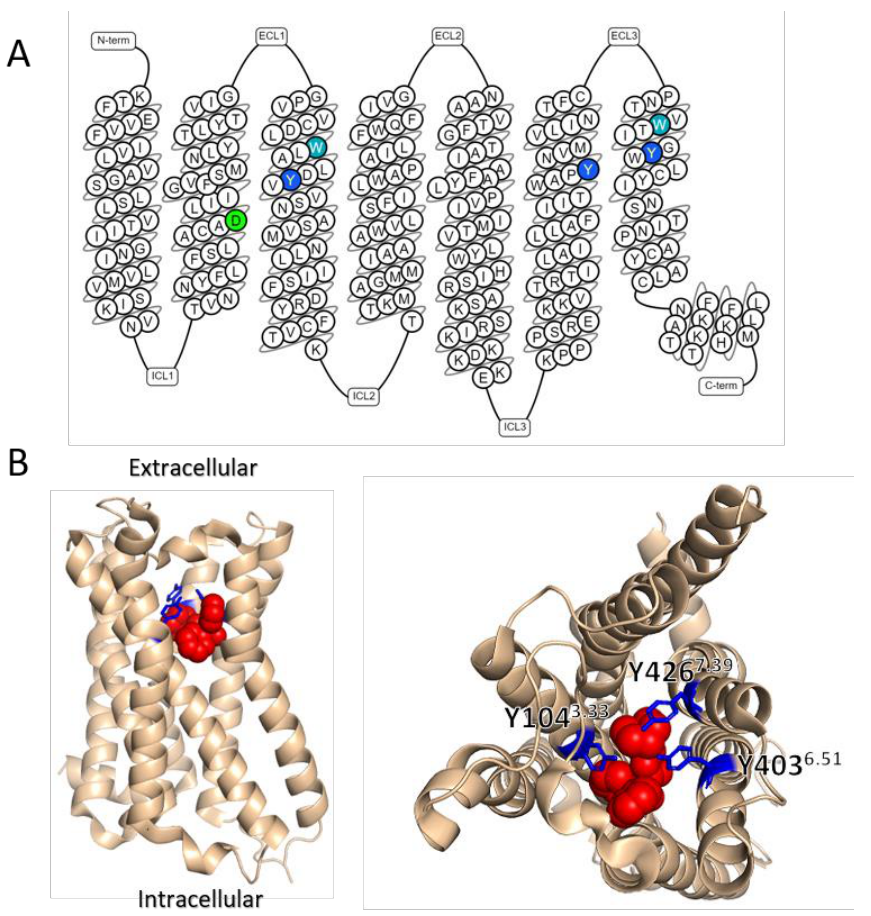
Figure 2. ( A ) Snake-like plot of the M2R (generated by GPCRdb.org [1]). Residues implicated in voltage sensing are labeled as follows: D69 2.50 (green), residues of the tyrosine lid (blue), and residues of the allosteric site (cyan). ( B ) Side (left) and top (right) view of the M2R based on structure PDB ID: 3OUN [50]. Here and in Figure 3, the antagonist QNB is shown in red to indicate the ligand binding site. The three tyrosine residues that form the tyrosine lid are labeled in blue.